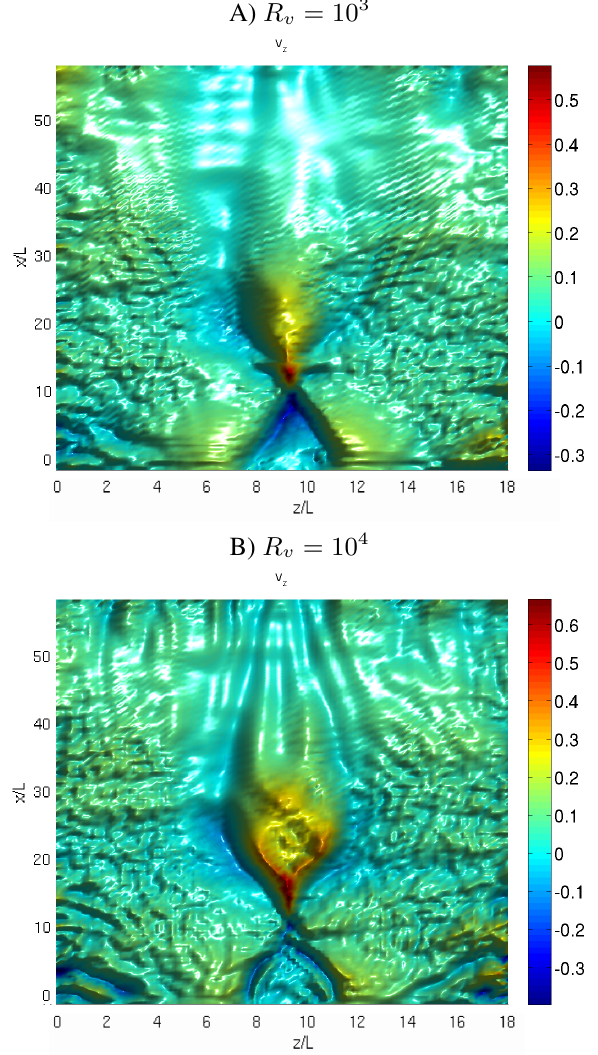
Fig. 11. Non-linear evolution of the initial 2-D helmet streamer equilibrium. False colour representation of the vertical speed away from the Sun u x (in the frame of reference of the Sun), at time t/τ A = 200. Two runs are shown with different viscosities (panel A : R v = 10 3 and panel B : R v = 10 4 ) but equal resistivity S = 10 4 . In the 1-D initial equilibrium, viscosity is shown to pro-